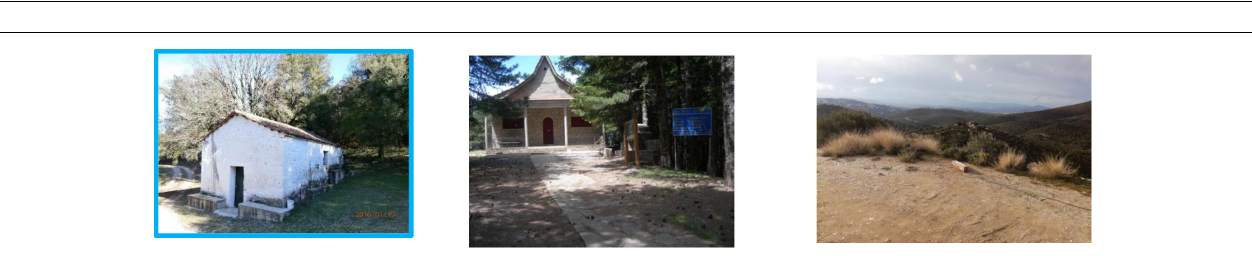
FIGURE 2 | Photos of the North (left) and South (middle) SR installations. Also shown is the testing site on Mount Penteli near suburb of Athens Drafi (right) .